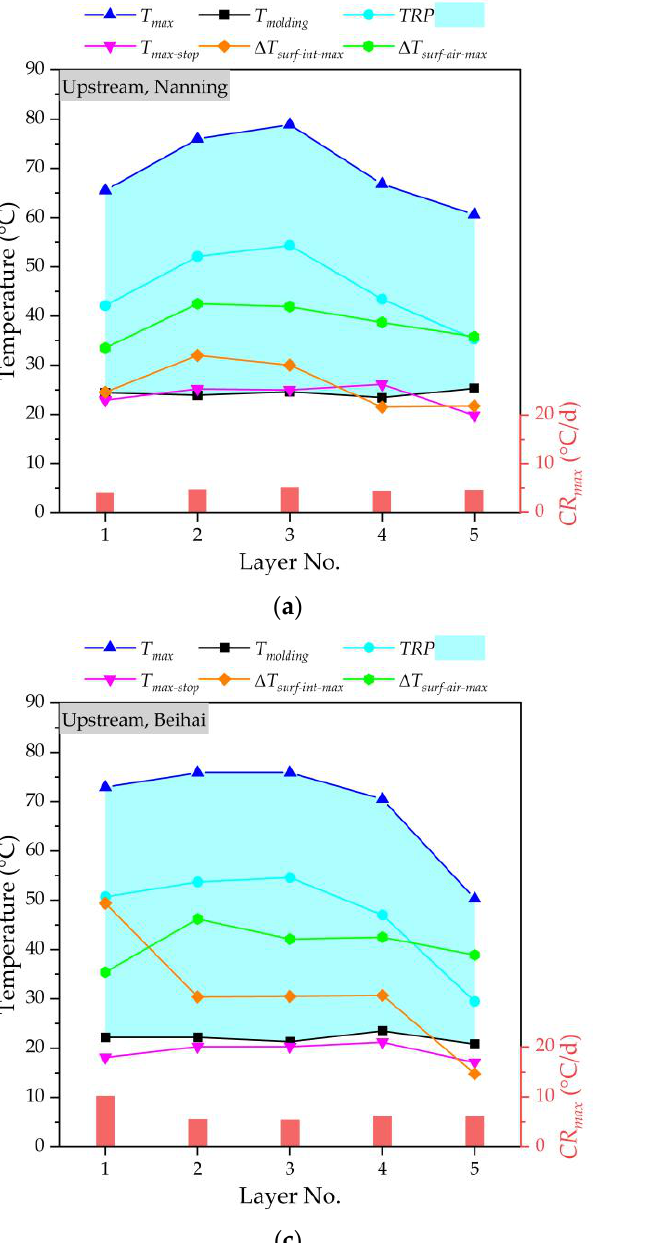
Figure 9. Temperature monitoring of mass concrete in the upper main pier: ( a ) at the upstream of Nanning side; ( b ) at the downstream of Nanning side; ( c ) at the upstream of Beihai side; ( d ) at the downstream of Beihai side.